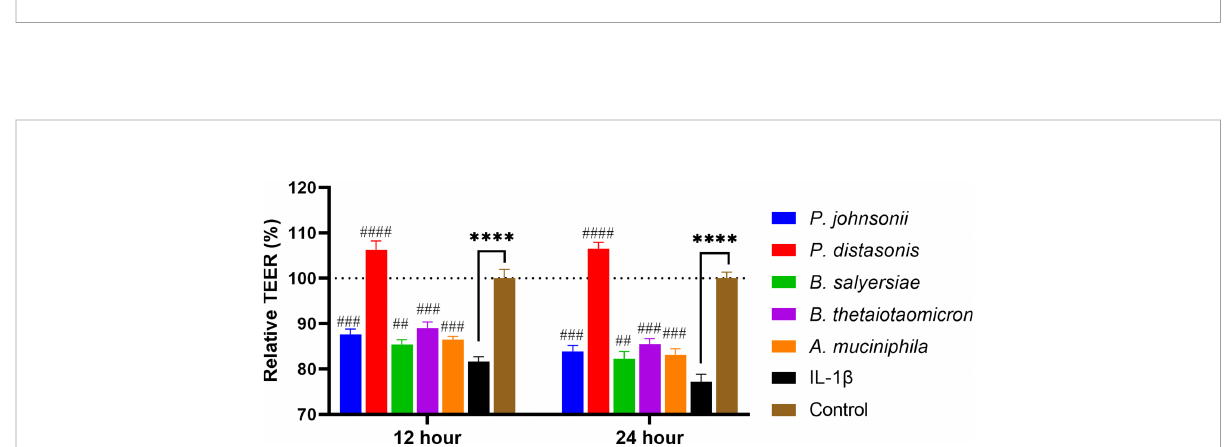
FIGURE 6 Selected mucin-degrading gut commensals attenuated the drop of TEER in Caco-2 cell monolayers induced by IL-1 b . Caco-2 cell monolayers treated with gut commensals were followed by stimulation by IL-1 b (10 ng/mL). The TEER value was measured at 12 h and 24 h time points. ****p < 0.0001 IL-1 b vs. control. ##p < 0.01, ###p < 0.001, ####p < 0.0001 IL-1 b vs. treated groups. Cells without any treatment were used as a control. Error bars represent the standard deviation of the mean values from at least three replicates. Signi fi cance was determined by one- way ANOVA followed by Dunnett ’ s test for multiple